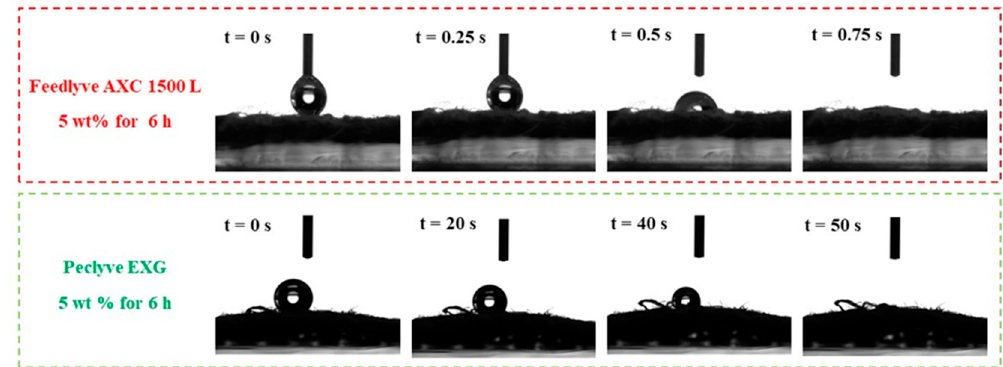
Figure 1. Representative time sequences of the water drop test performed on the flax fabrics treated with Feedlyve and Peclyve at 5 wt % for 6 h.